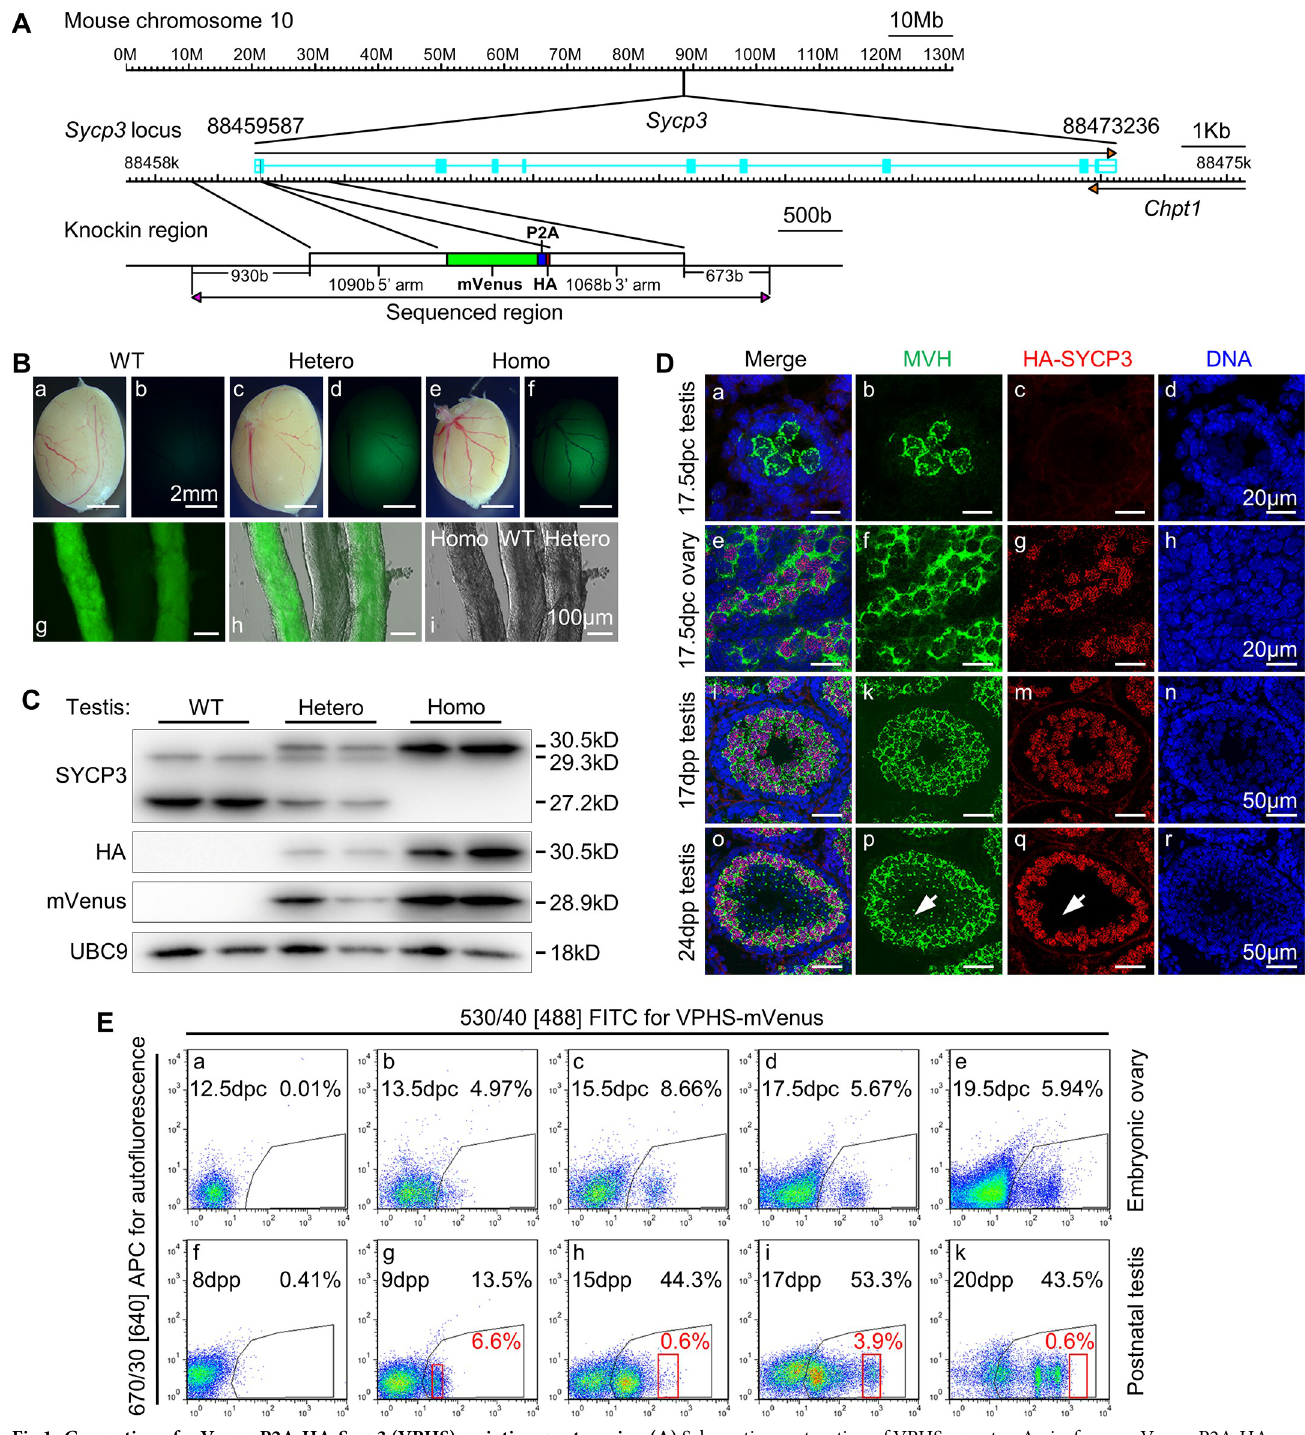
Fig 1. Generation of mVenus-P2A-HA-Sycp3 (VPHS) meiotic reporter mice. (A) Schematic construction of VPHS reporter. An in-frame mVenus-P2A-HA expression cassette was inserted right after the start codon of Sycp3 . The reporter cassette is flanked by about 1kb long homologous arm at both sides in donor vector. (B) Detection of VPHS transgenic reporter fluorescent in 8-week-age testis. Abbreviations (the same as below): WT, wild type; Hetero, heterozygote; Homo, homozygote. (C) Western analysis of VPHS transgene product in adult testis with different VPHS genotypes. Target band were indicated by predicted molecular weight. The three SYCP3 bands were HA-SYCP3 (30.5kD), wild type longer SYCP3 isoform (29.3kD) and wild type shorter SYCP3 isoform (27.2kD), respectively. UBC9 served as loading control. n = 2 animals/genotype. See S1E–S1G Fig for whole Western blot results. (D) Localization of HA-SYCP3 in VPHS homozygote gonads by fresh-frozen immunostaining. Germ cells were localized by cytoplasmic marker MVH. Abbreviations: dpc, day postcoitum; dpp, day postpartum. (E)